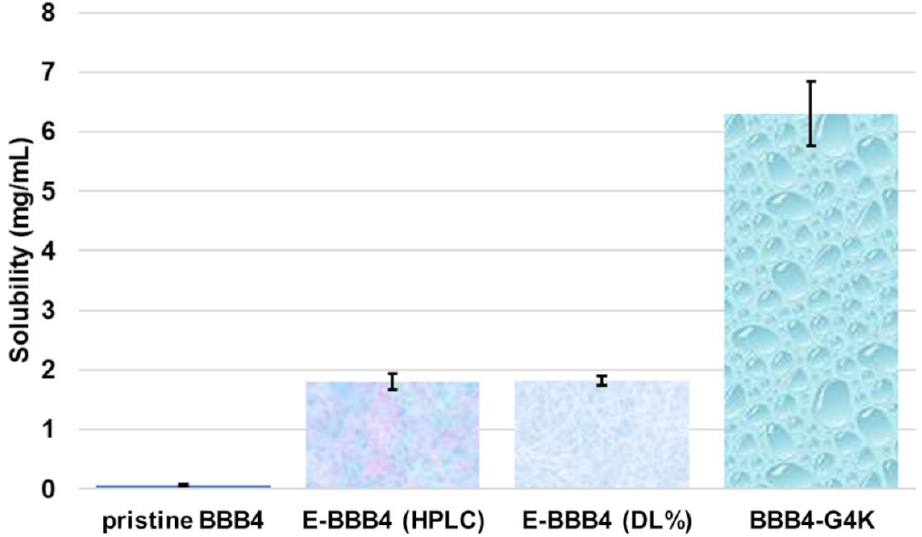
Figure 10. Water solubility of pristine BBB4, of nanotechnologically manipulated BBB4 released in water solution (E-BBB4 (HPLC)), of BBB4 contained in NPs (E-BBB4 (DL%)), and of BBB4-G4K NPs, reported as a mean ± SD.